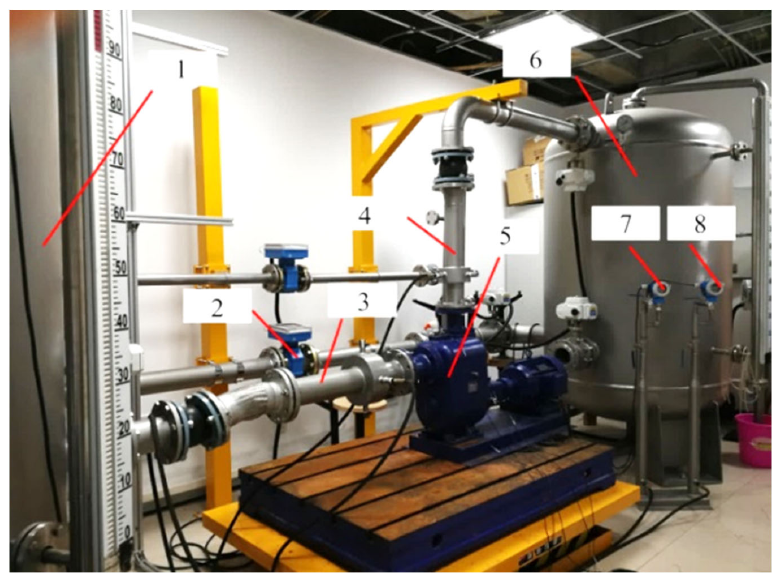
Figure 4. Test rig for the pump: (1) inlet tank; (2) flow meter; (3) inlet pipe with pressure detecting port; (4) outlet pipe with pressure detecting port; (5) test pump; (6) outlet tank; (7) inlet pressure transducer; (8) outlet pressure transducer.